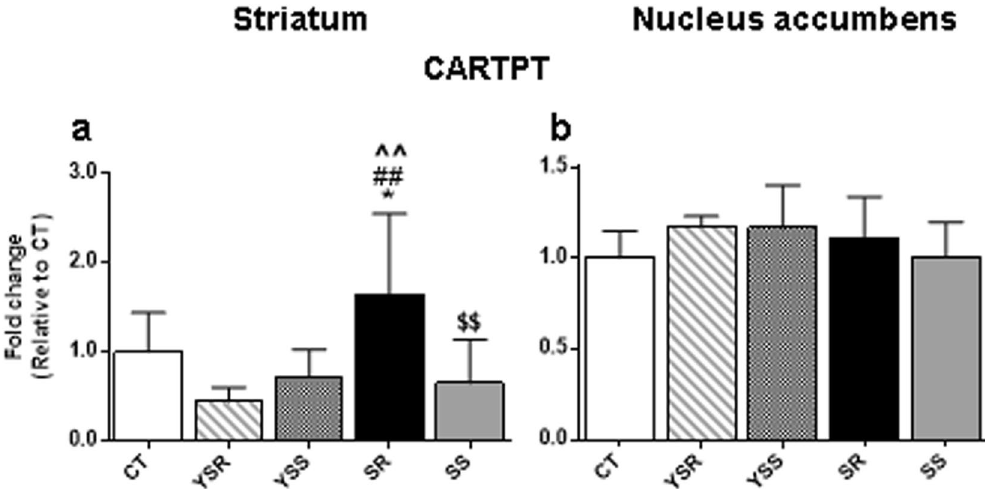
Figure 5. PCR validation of changes in CARTpt mRNA expression in the dorsal striatum after a month withdrawal from methamphetamine SA and footshocks. We conducted quantitative PCR using individual RNA from the dorsal striatum ( a ) and NAc ( b ) of rats. The shock-resistant rats showed significant increases in CARTpt in the dorsal striatum ( a ) but not in the NAc ( b ). Values are means ± SEM fold changes relative to the control group. Key to statistics: * p < 0.05, in comparison to the control group; ##p < 0.01, in comparison to YSR rats; ^^p < 0.01, in comparison to the YSS group; $$p < 0.01 in comparison to the SR